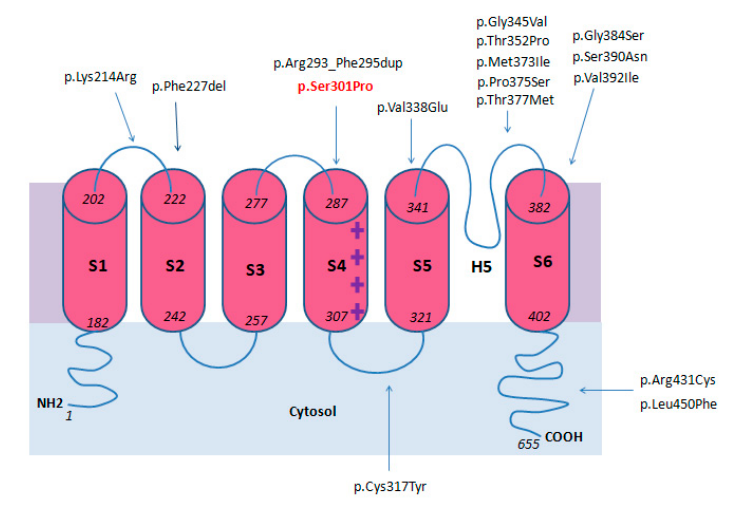
Figure 3. Locations of reported variants in KCND3 domains. Table 3. Genotype data of KCND3 pathogenetic variants reported in literature.